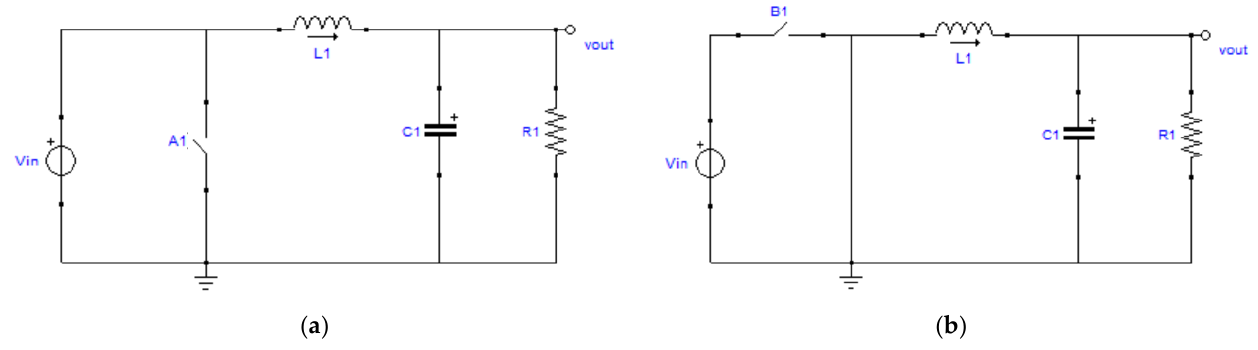
Figure 4. Topologies of a buck converter: ( a ) switch-on period; ( b ) switch-off